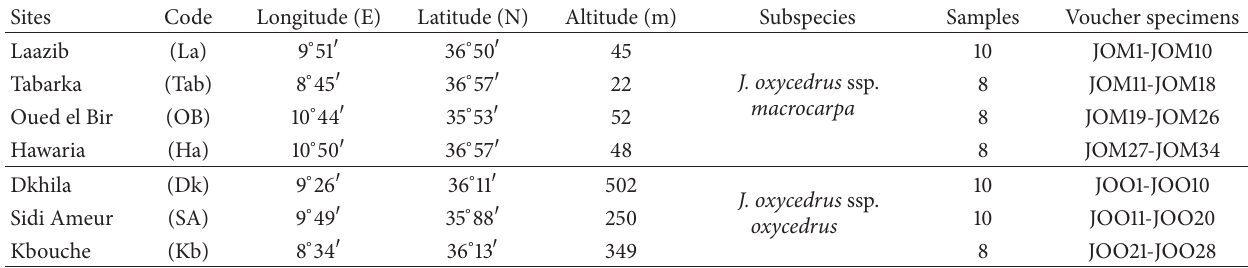
Table 1: Geographical coordinates of the sites of collection of Juniperus